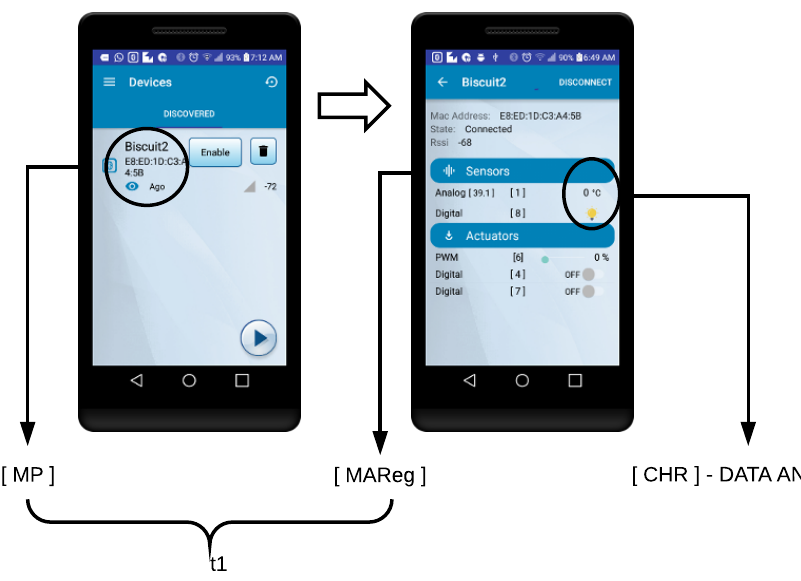
Figure 30. Sequence of screens of the Android application when using the GATT-based